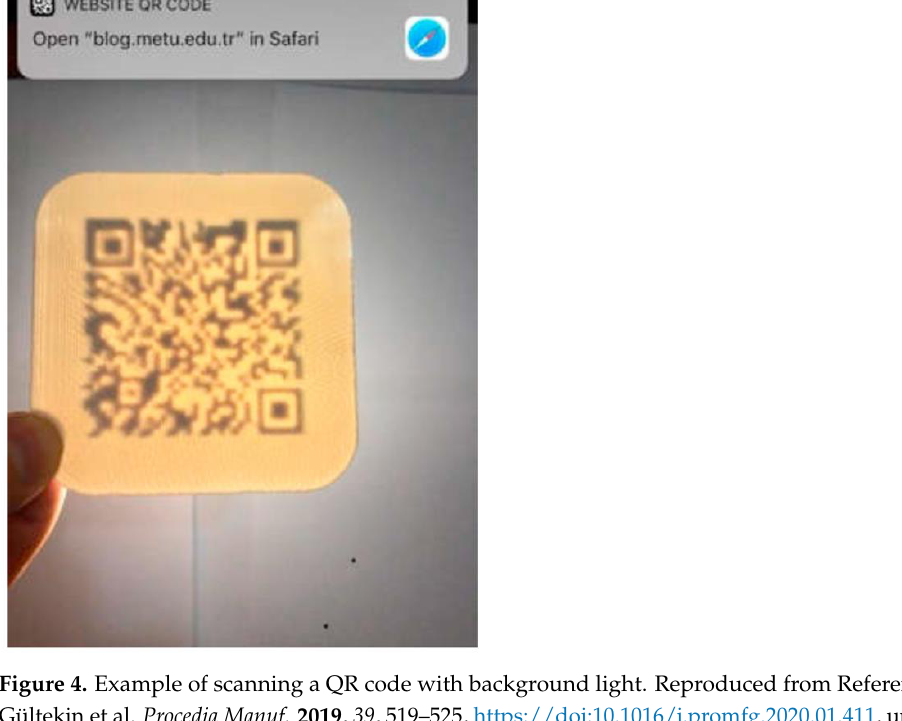
Figure 6. Simplified flowchart of the fabrication process proposed by Jaiswal et al. [26] to produce UV-visible micron-sized QR codes for TPL parts. The first step in the fabrication process required to spin-coat the emissive resin on a glass substrate and to fabricate the QR code using laser-induced two-photon polymerisa- tion. The unexposed (uncured) resin was selectively removed in N,N dimethyl formamide and then a layer of non-emissive resin was spin-coated on top of the QR code to hide and protect it. Lastly, five layers of non-emissive resin were added with layer-by-layer writing in order to make the QR code completely invisible under optical illumination, but still visible under UV light. In addition to concealing the code, the non-emissive resin coat avoided any damage from wear and tear. Two-photon-assisted fabrication offers several advantages, as it is well known for its reproduction fidelity and for its scalability with a voxel size as small as 140 nm for linear structures and approximately 200 nm for more complicated 2D patterns (with a voxel being the building block of structures produced in two-photon polymerisation-assisted fabrication) [26]. Jaiswal et al. [26] demonstrated the accuracy and repeatability of QR codes fabricated over an area of 100 × 100 μm 2 as exem- plified in Figure 7a. A glass coverslip was used as the substrate for demonstrative pur- poses. The detail in Figure 7c shows that each area of the QR code, in its turn, is composed